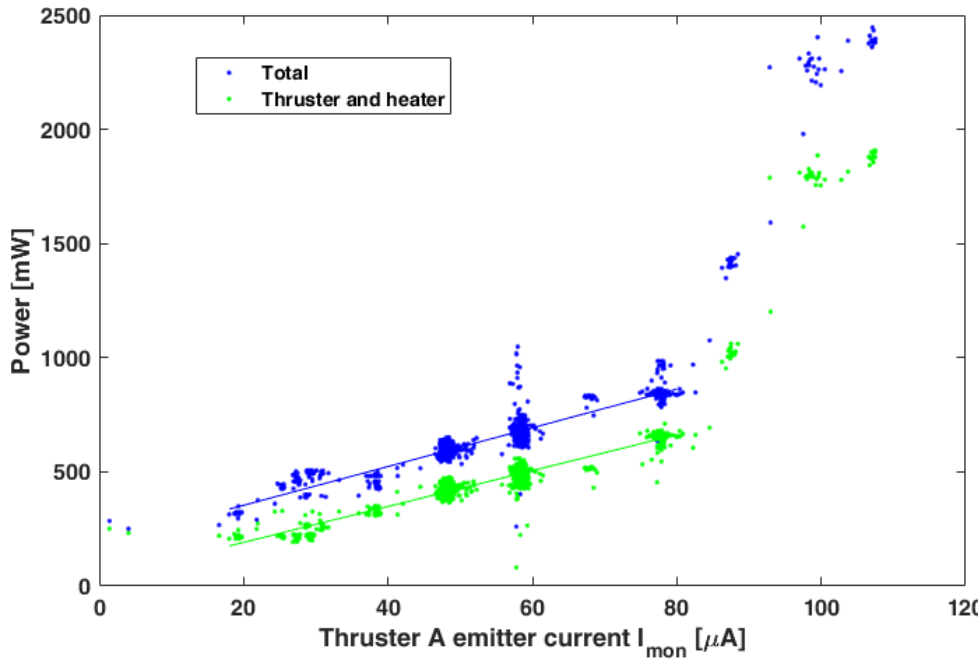
Figure 10. Power consumption vs. emitter current of thruster A. The total power consumption is depicted in blue, the power consumption of thruster A and its heater in green.